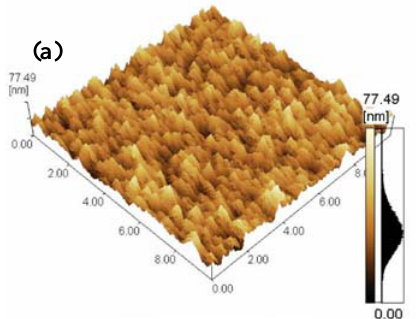
Indenter shape (number of repeats) Berkovich Conical